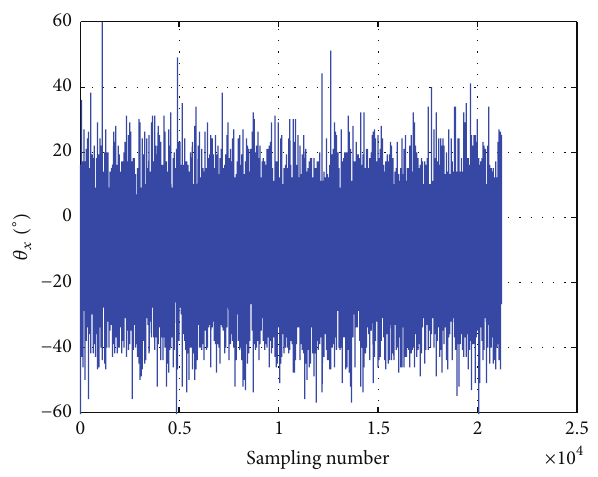
Figure 8: 𝜃 𝑥 for uncontrolled system.